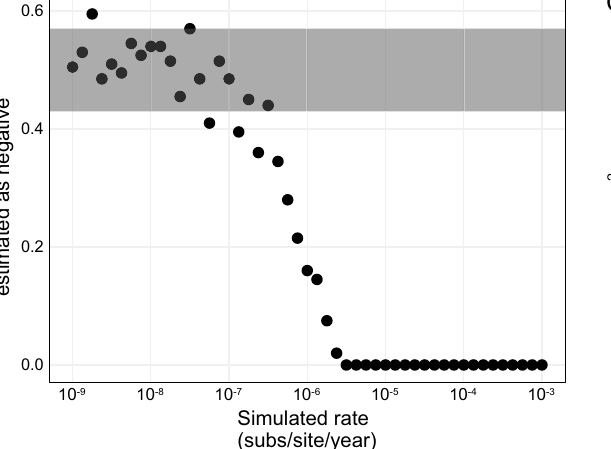
have a rate estimated as negative. Gray shading represents range for which a negativeestimateisequallyprobableaspositive(two-sidedbinomialtest p <0.05). C R 2 coef fi cient of determination of root-to-tip regression, a transparent dot represents one replicate. 200 replicates of simulated sequences were generated under GTR+F+ Γ 4 model then clock rate estimated on simulated sequences; code to produce the simulation results is at